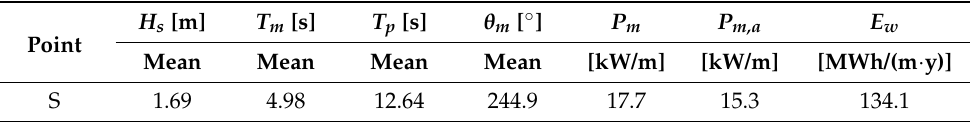
Table 3. Main wave climate parameters, whole yearly average wave power, available yearly wave